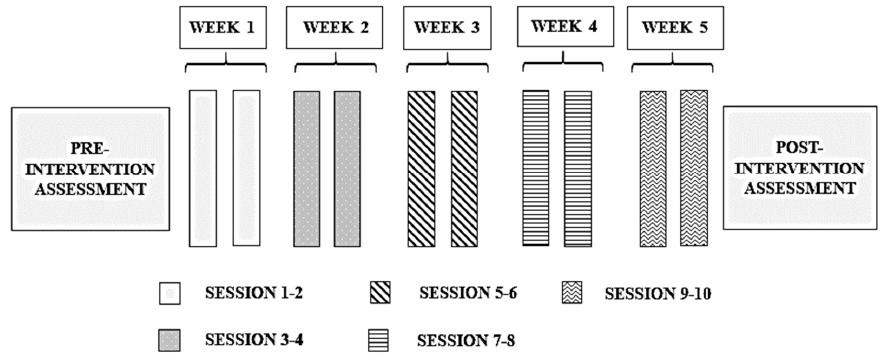
Figure 2. Phases of the intervention program.